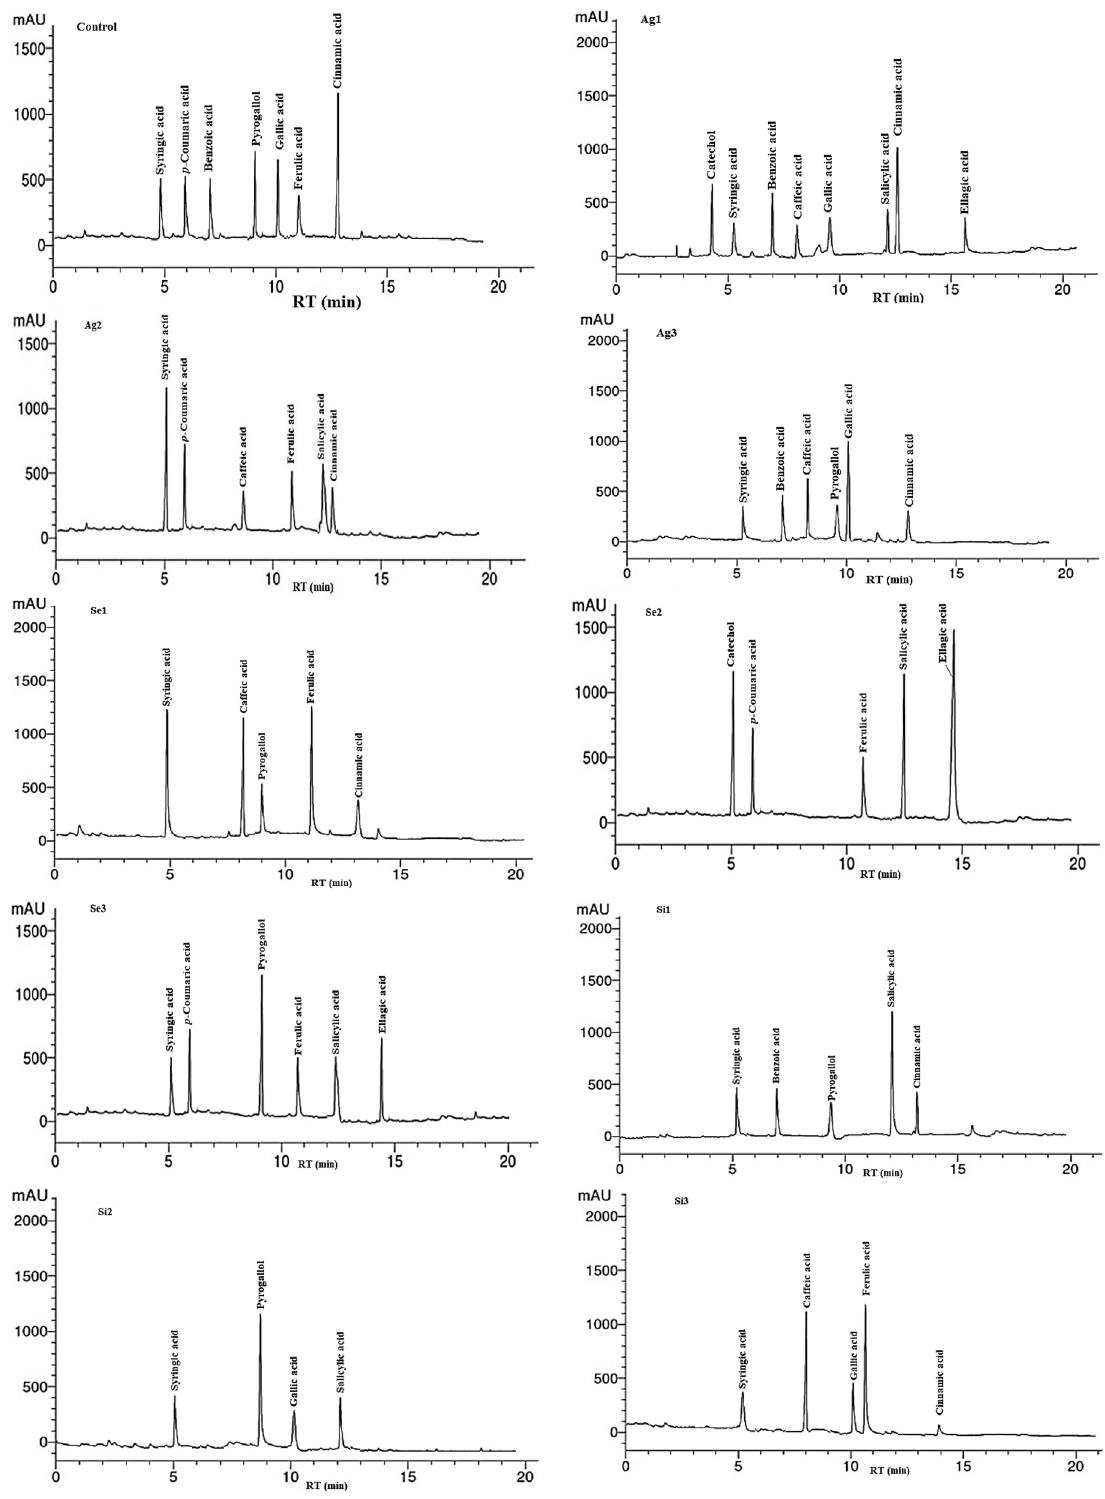
Figure 2. HPLC chromatograms of phenolic compounds from acetone extracts of pomegranate peels fruits treated with Ag1: 5 mL/L Ag NPs; Ag2: 7.5 mL/L Ag NPs; Ag3: 10 mL/L Ag NPs; Se1: 0.025 mg/L Se; Se2: 0.05 mg/L Se; Se3: 0.1 mg/L Se; Si1: 0.5 mg/L K 2 Si 2 O 5 ; Si2: 1 mg/L K 2 Si 2 O 5 ; Si3: 2 mg/L K 2 Si 2 O 5